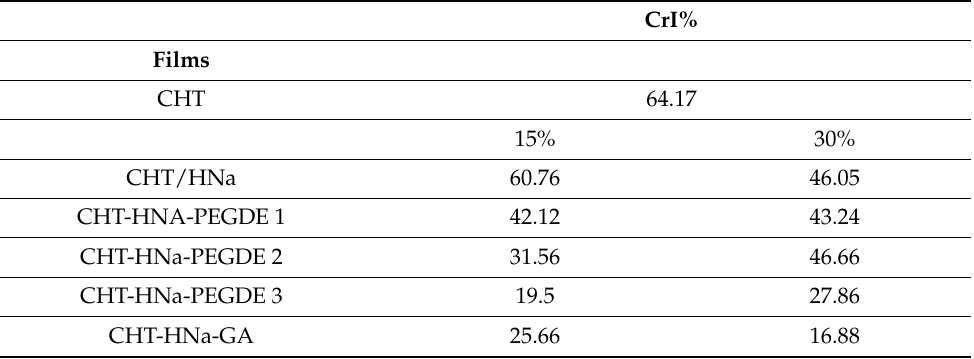
Table 3. Percentage of the crystallinity of the chitosan/HNa films without crosslinker and with crosslinker of GA and PEGDE.